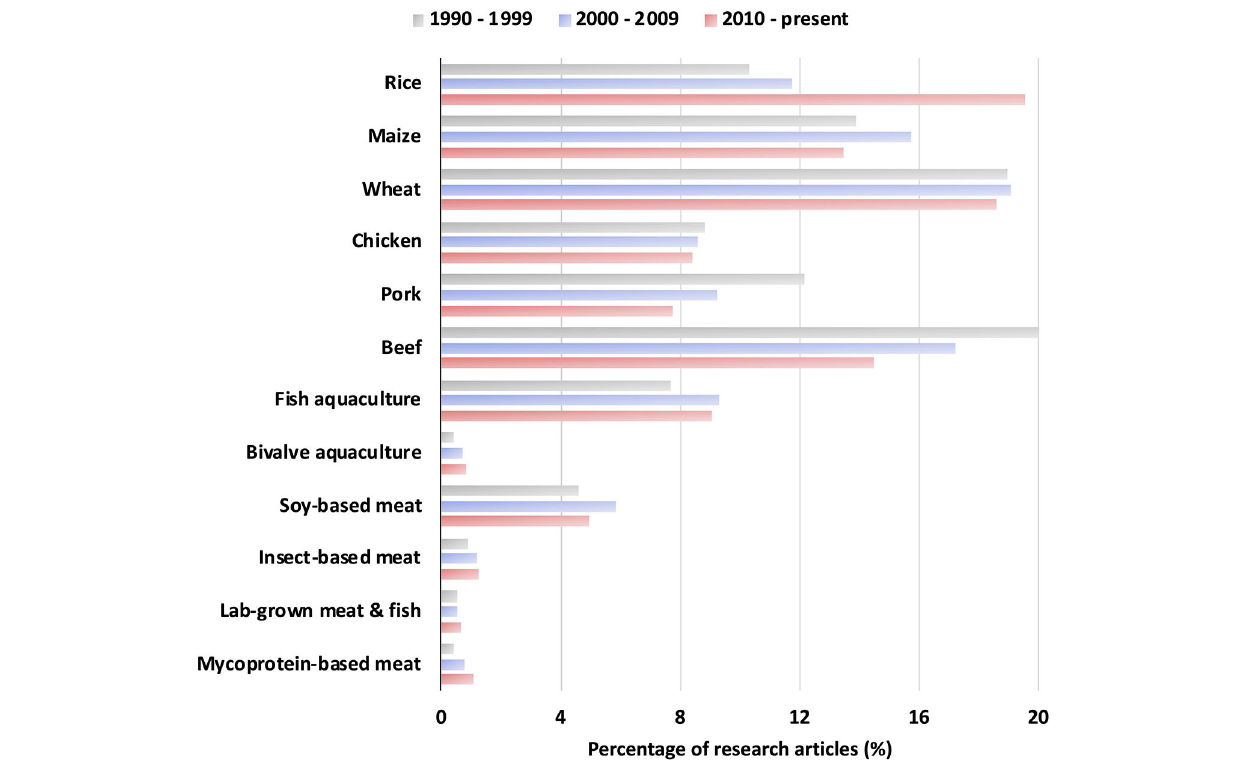
FIGURE 1 | Percentage of all research articles published corresponding to key food types across each decade. Many food sources with a high sustainability and nutritional potential (bivalve aquaculture and below) continue to receive relatively low levels of research investment. Scopus ( Elsevier, 2020) was used to count the total number of peer-reviewed publications corresponding to each food type between the dates 1990–1999, 2000–2009, and 2010–12/05/2020. Five most relevant search phrases were selected for each food type. To be counted articles had to include any one of the search phrases in the abstract, title or keywords. Search phrases were as follows. Rice: “rice farm,” “rice production,” “rice industry,” “rice food,” “rice field.” Maize: “maize farm,” “maize production,” “maize industry,” “maize food,” “maize field.” Wheat: “wheat farm,” “wheat production,” “wheat industry,” “wheat food,” “wheat field.” Chicken: “poultry farm,” “poultry production,” “chicken farm,” “chicken production,” “broiler farm.” Pork: “pork farm,” “pig farm,” “pork production,” “pig production,” “swine farm.” Beef: “beef farm,” “cattle farm,” “cow farm,” “cattle production,” “beef production.” Fish aquaculture: “fish farm,” “fish aquaculture,” “pisciculture,” “fish mariculture,” “fish hatchery.” Bivalve aquaculture: “bivalve aquaculture,” “bivalve farm,” “clam farm,” “mussel farm,” “oyster farm.” Soy-based meat: “tofu,” “tempeh,” “soy-based meat,” “soy protein,” “miso.” Insect-based meat: “insect meat,” “insect flour,” “insect food product,” “insect snack,” “insect burger.” Lab-grown meat and fish: “lab-grown meat,” “cultured artificial meat,” “lab-grown fish,” “ in vitro meat,” “cell-based meat.” Mycoprotein-based meat: “mycoprotein,” “quorn,” “fusarium venenatum,” “fungiculture protein,” “fungal protein